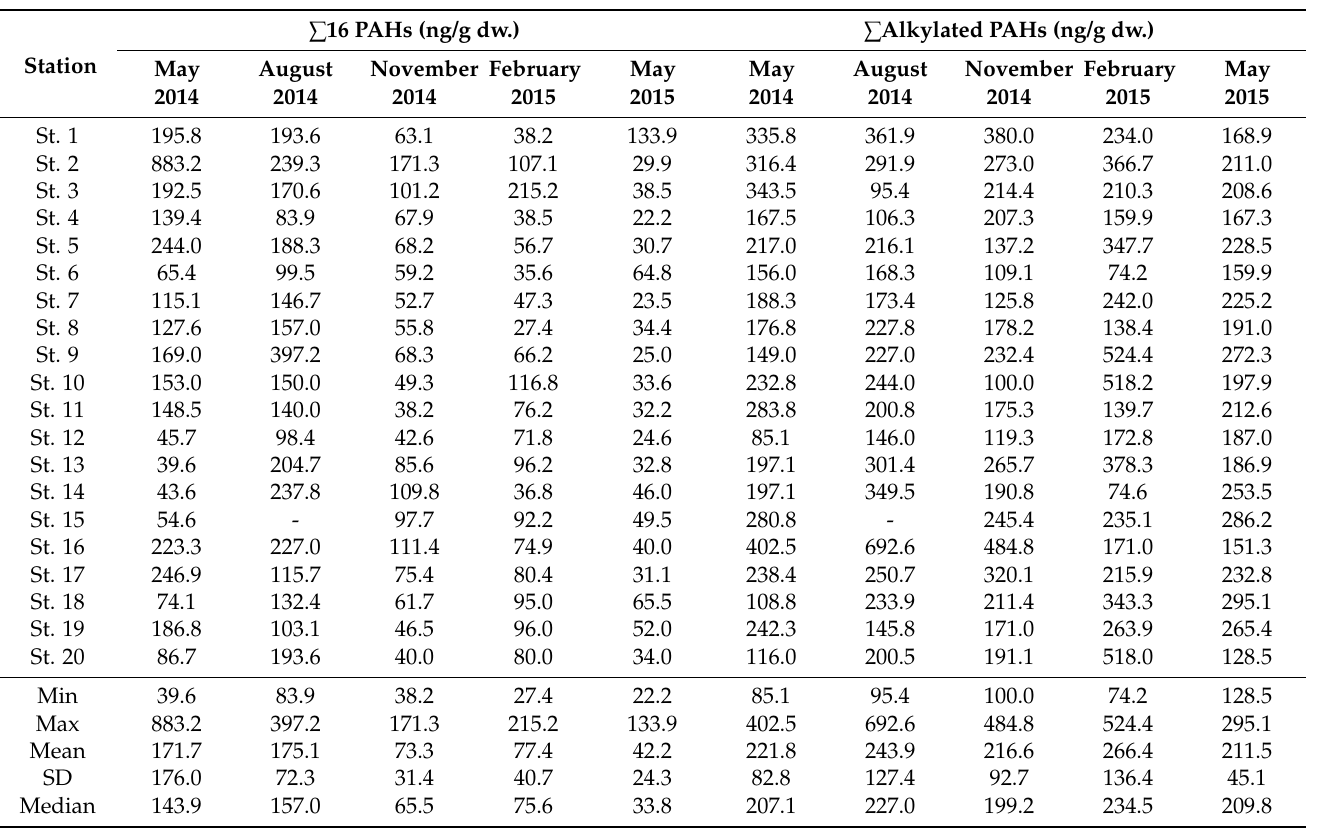
Table 4. Total concentrations of 16 PAHs and alkylated PAHs in sediments from Gwangyang Bay and the Yeosu